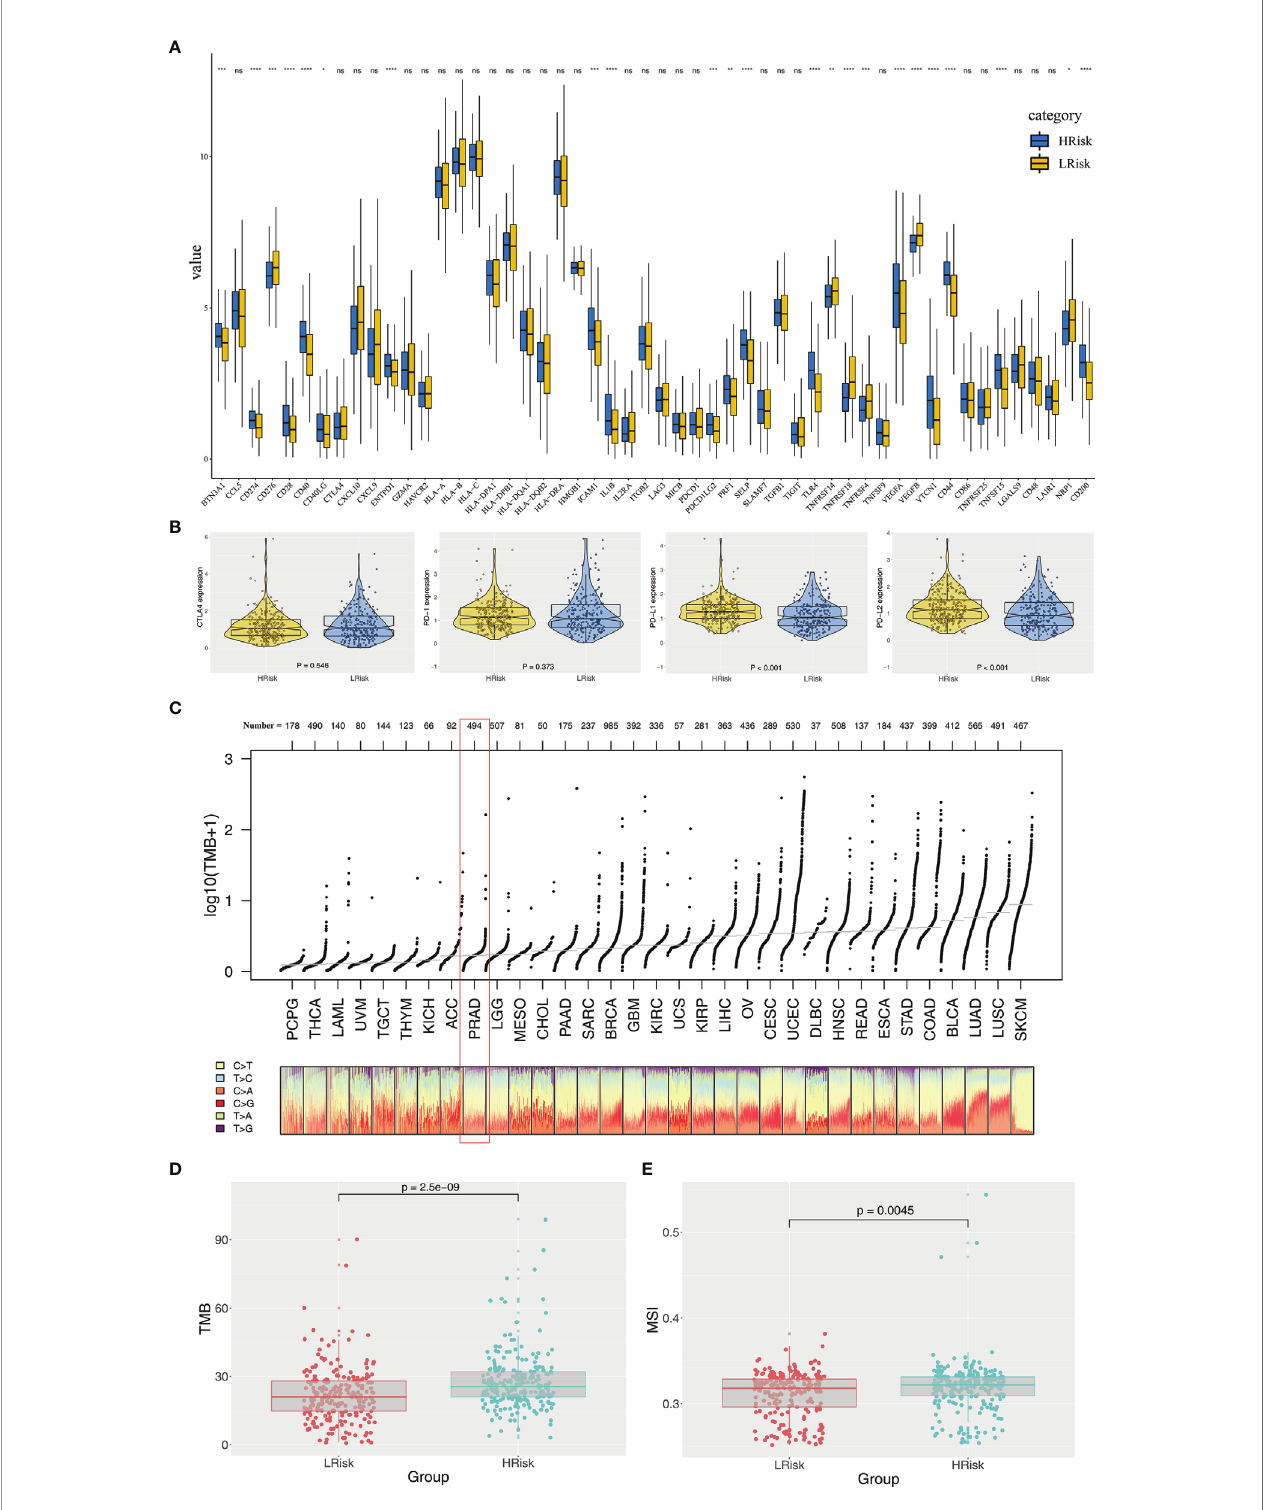
FIGURE 5 | Exploration of the difference of immune checkpoint genes, TMB, and MSI in high and low IRS groups. (A) Signi fi cant differences were observed in multiple immune checkpoint genes between high and low IRS groups. (B) High IRS PRAD patients showed a higher level of PD-1. (C) Overview of TMB distribution in TCGA pan cancer. (D, E) High IRS PRAD patients showed a higher level of TMB and MSI. *P < 0.05; **P < 0.01; ***P < 0.001; ****P < 0.0001; ns, no signi fi